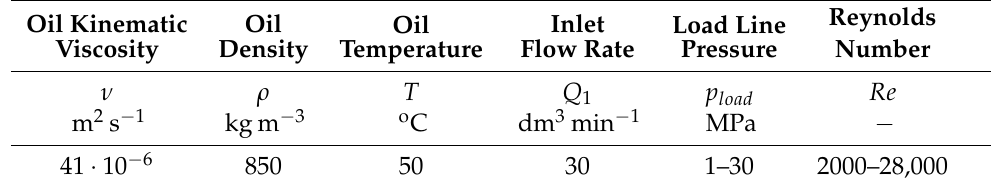
Table 2. Physical